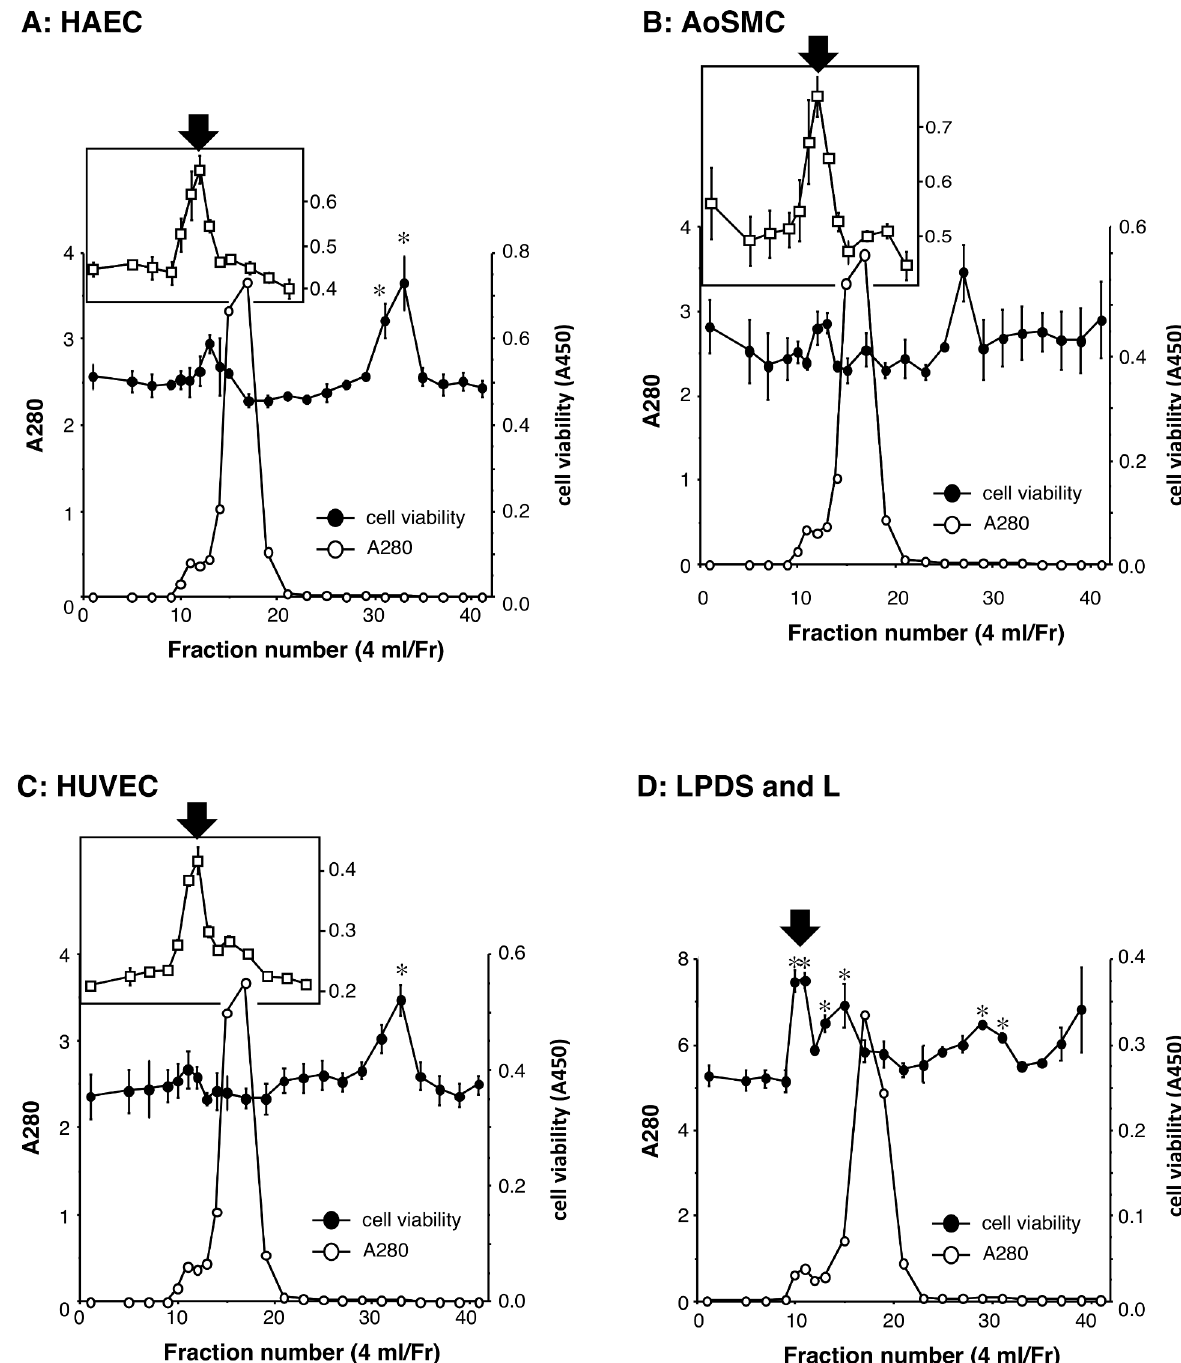
Fig 3. Effects of oxidized lipoprotein deficient serum on the viability of vessel cells. A-C. Oxidized lipoprotein deficient serum (LPDS) were fractionated by Sephacryl S-300 gel chromatography, and protein contents were determined by absorbance at 280 nm. HAEC ( A ), AoSMC ( B ), and HUVEC ( C ) were treated with each fraction (10%) for 48h, and the viability was measured by WST assay. The cell viability in the case of oxidized human serum fractions are shown in inner figure. D. LPDS and extracted lipid fraction (L) were mixed, oxidized, and then fractionated by Sephacryl S-300 gel chromatography. HAEC was treated with each fraction (10%) for 48h, and the viability was measured. The maclomolecule proliferator for vessel cells at Fr.12 is indicated by black arrow. * P < 0.01, compared with vehicle